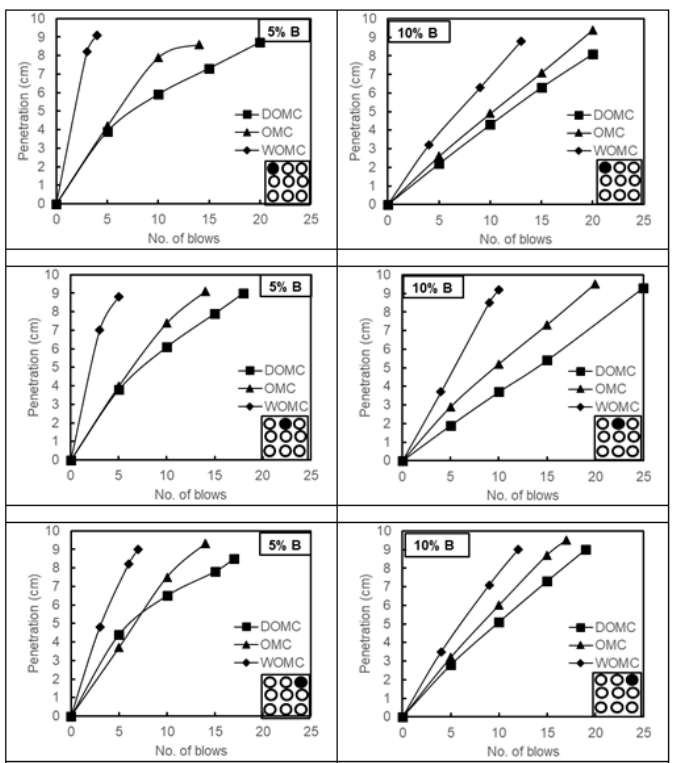
Figure 6. Penetration profiles for three points located along the top row (3) for 5% and 10% bentonite mixtures .